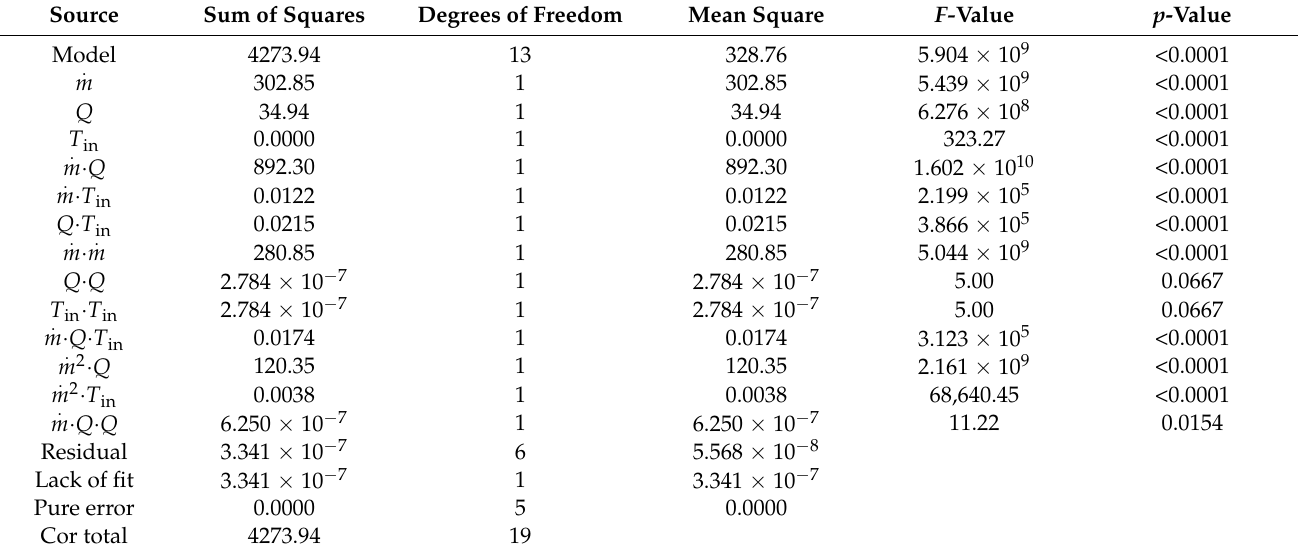
Table A2. The ANOVA for the maximum temperature difference (after backward elimination).